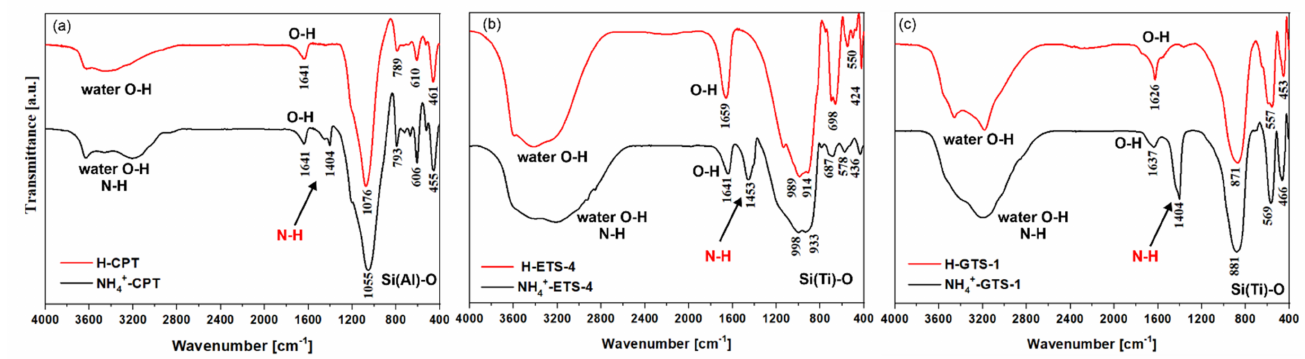
Figure 4. Comparative FTIR spectra of the H- and NH 4+ -forms of ( a ) CPT, ( b ) ETS-4, and ( c )